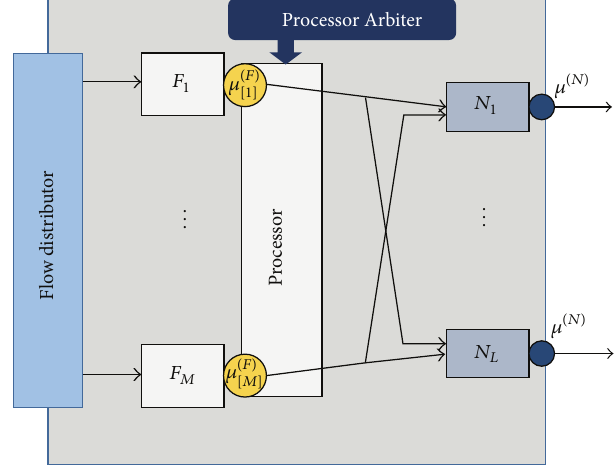
Figure 2: NFV node functional